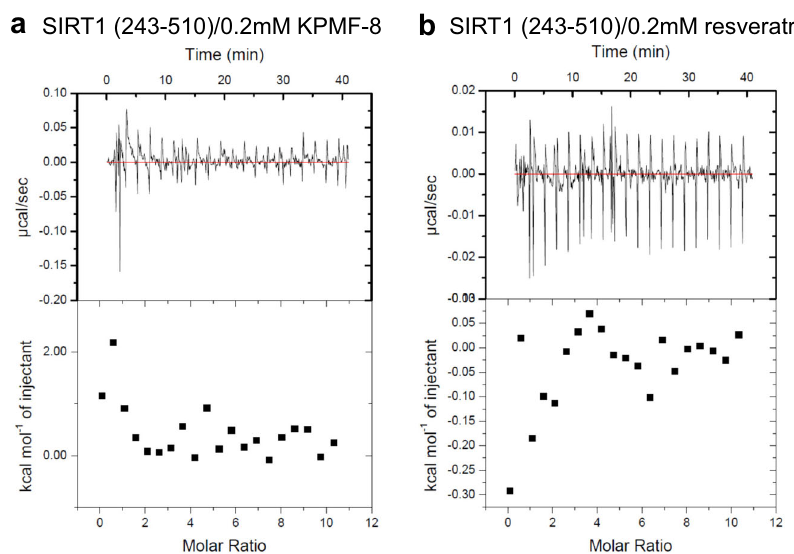
Fig. 2 Binding of KPMF-8 or resveratrol to SIRT1 (243 – 510) determined using ITC. a Binding of KPMF-8 to SIRT1 (243 – 510). b Binding of resveratrol to SIRT1 (243 –